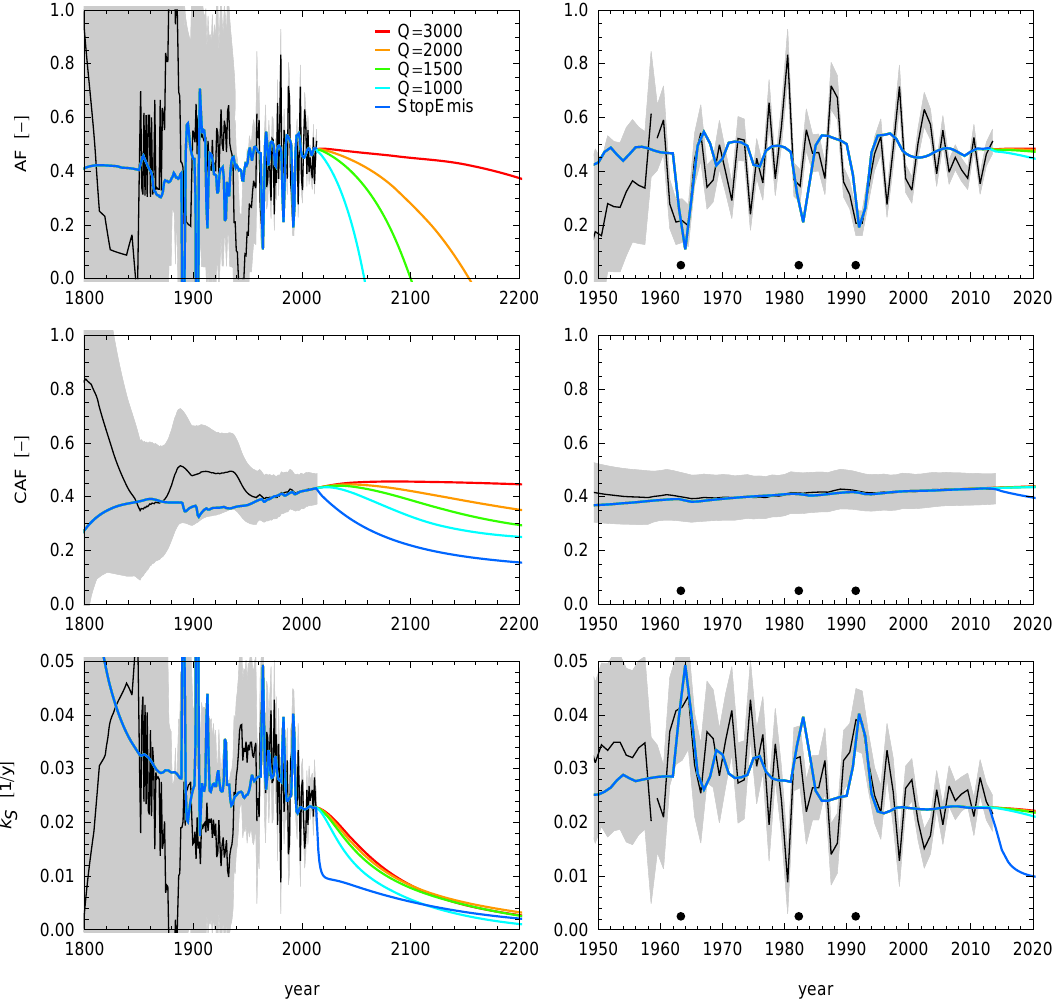
Figure 5. Trajectories of AF and k S (upper and lower rows) for the analytic scenarios shown in Fig. 4. Dots in right (zoom) panels indicate times of major volcanic eruptions since 1959 (Agung, El Chichon, Pinatubo). Black lines are observations; grey bands indicate ± 1 σ ranges due to observation uncertainties in emissions and CO 2 concentrations. Historical SCCM results (prior to 2013.0) appear as blue in all panels. Other details follow Fig. 4. This figure is a variation with added detail of Fig. 7 in Raupach